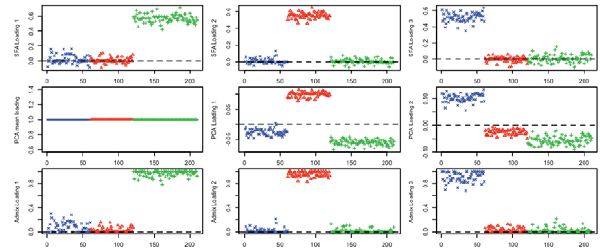
Figure 3. Results of applying SFA, PCA, and ADMIXTURE to the HapMap genotype data. Each plot shows the estimated loadings ( y - axis) across individuals ( x -axis). SFA loadings are in the first row, PCA loadings in the second, and ADMIXTURE loadings in the third. European individuals are denoted with blue ‘x’s, African individuals are denoted with red triangles, and Asian individuals are denoted with green ‘ + ’s. A dashed horizontal line is at zero on the y -axis. doi:10.1371/journal.pgen.1001117.g003 PLoS Genetics |